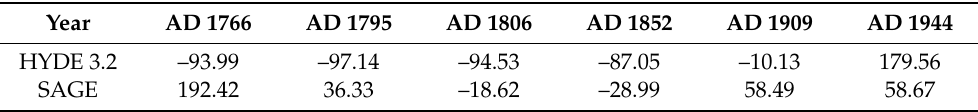
Figure 4. The changing trends of cropland area in the northern piedmont of the Tianshan Mountains in Xinjiang area (AD 1766–1944) from HYDE 3.2, SAGE, and Zhang datasets. The relative difference rate indicates that the cropland areas in these global datasets in the northern piedmont of Tianshan Mountains are significantly different from those in the Zhang dataset (Table 4). Pre-1910, the cropland areas of the northern piedmont of the Tianshan Mountains in HYDE 3.2 are significantly lower than that in the Zhang dataset; post-1910, the former is significantly greater than the latter. Specifically, for AD 1790 and 1940, the relative difference rates between HYDE 3.2 and the Zhang dataset are –97.14% and 179.56%, respectively. Although the cropland areas in the northern piedmont of the Tianshan Mountains in SAGE are generally close to those in the Zhang dataset, the relative difference rates between the two datasets still reach up to 192.42% and 58.67% in AD 1770 and 1940, respectively. Table 4. The relative difference rates between HYDE 3.2, SAGE, and the Zhang dataset from AD 1770 to 1940 in the northern piedmont of the Tianshan Mountains (unit: %).